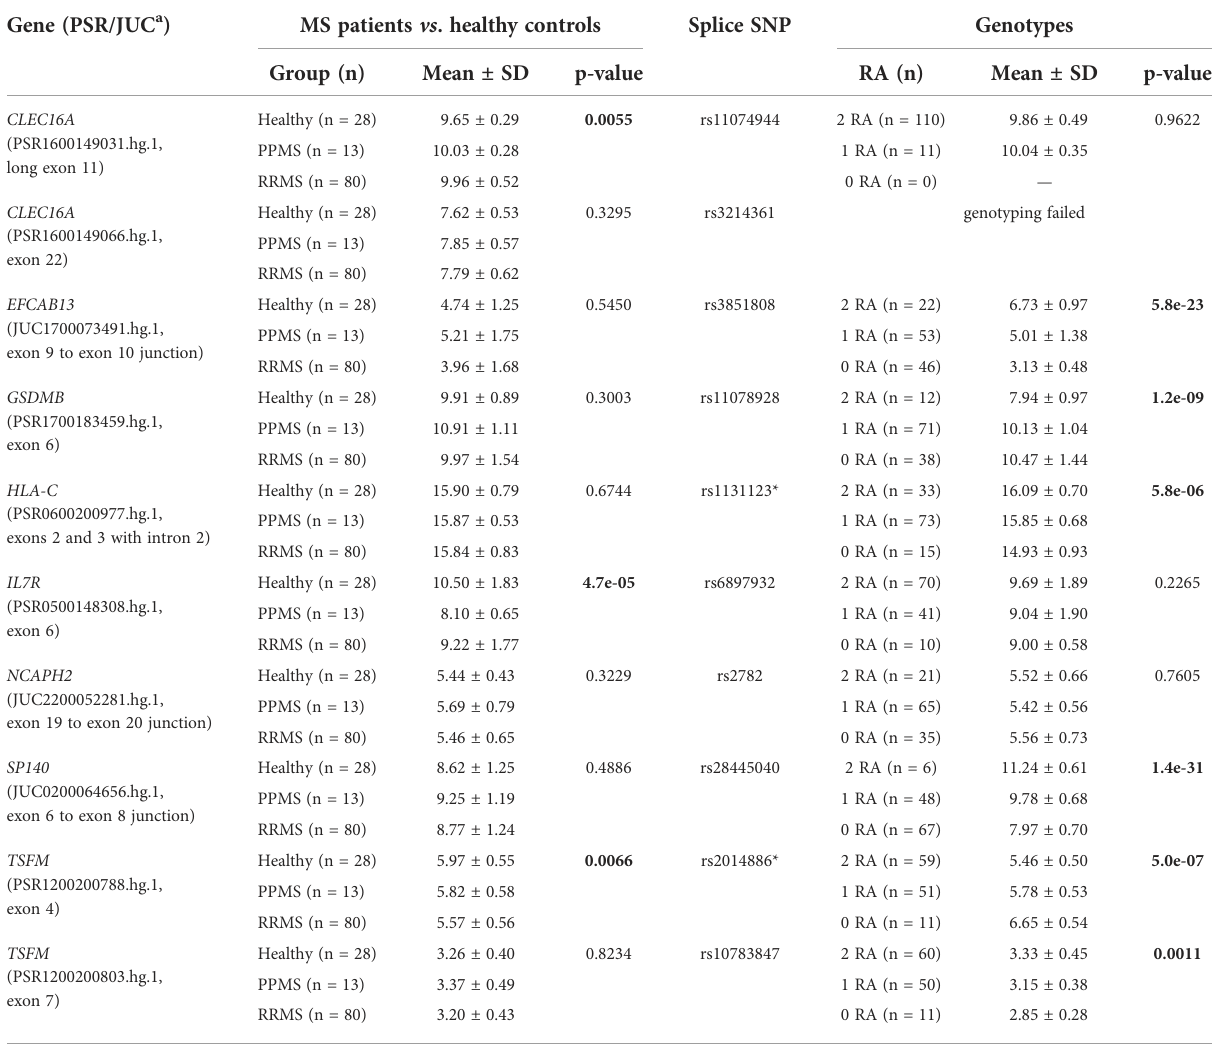
TABLE 4 Differential alternative splicing in the B-cell transcriptome data set. Gene (PSR/JUC a ) MS patients vs . healthy